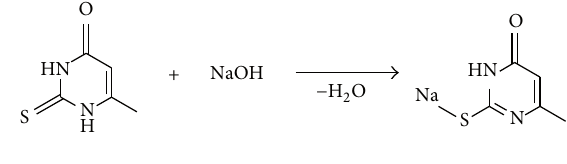
F 3: Syntheses of copper di(2(-1,6-dihydro-4-methyl-6- oxopyrimidin-2-yl-thio)ethanoate (III).